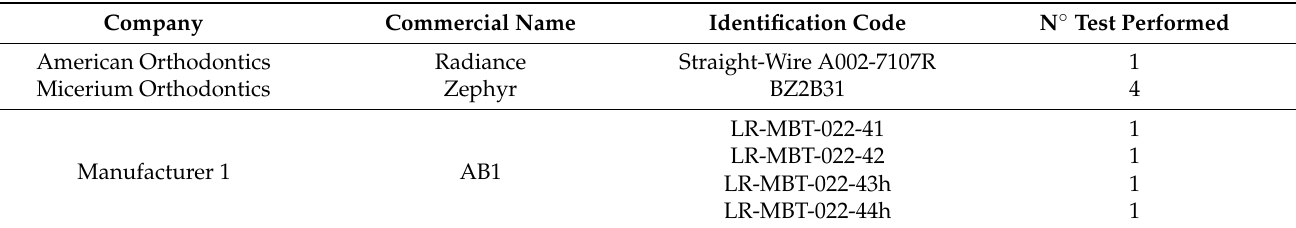
Table 1. Aesthetic brackets tested.